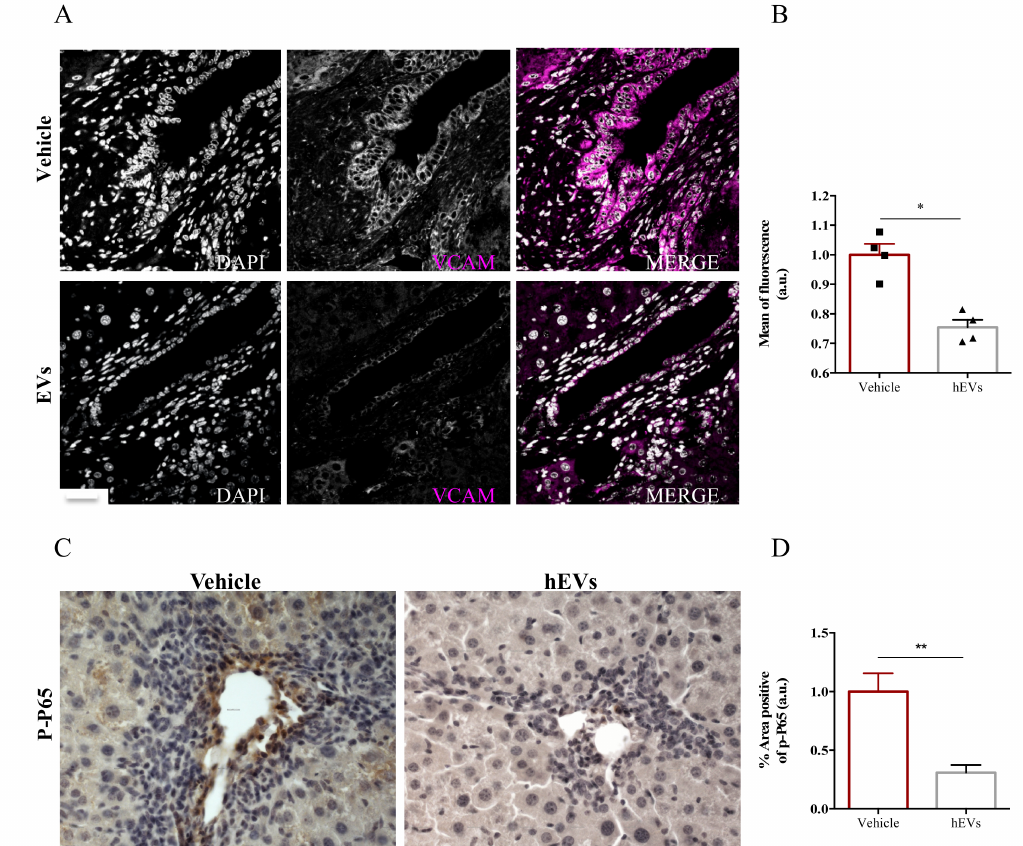
Figure 4. EV administration reduces VCAM-1 expression by the inflamed liver endothelium. ( A ) Representative images of VCAM-1 immunostaining (magenta) in liver sections from FVB.Mdr2 − / −